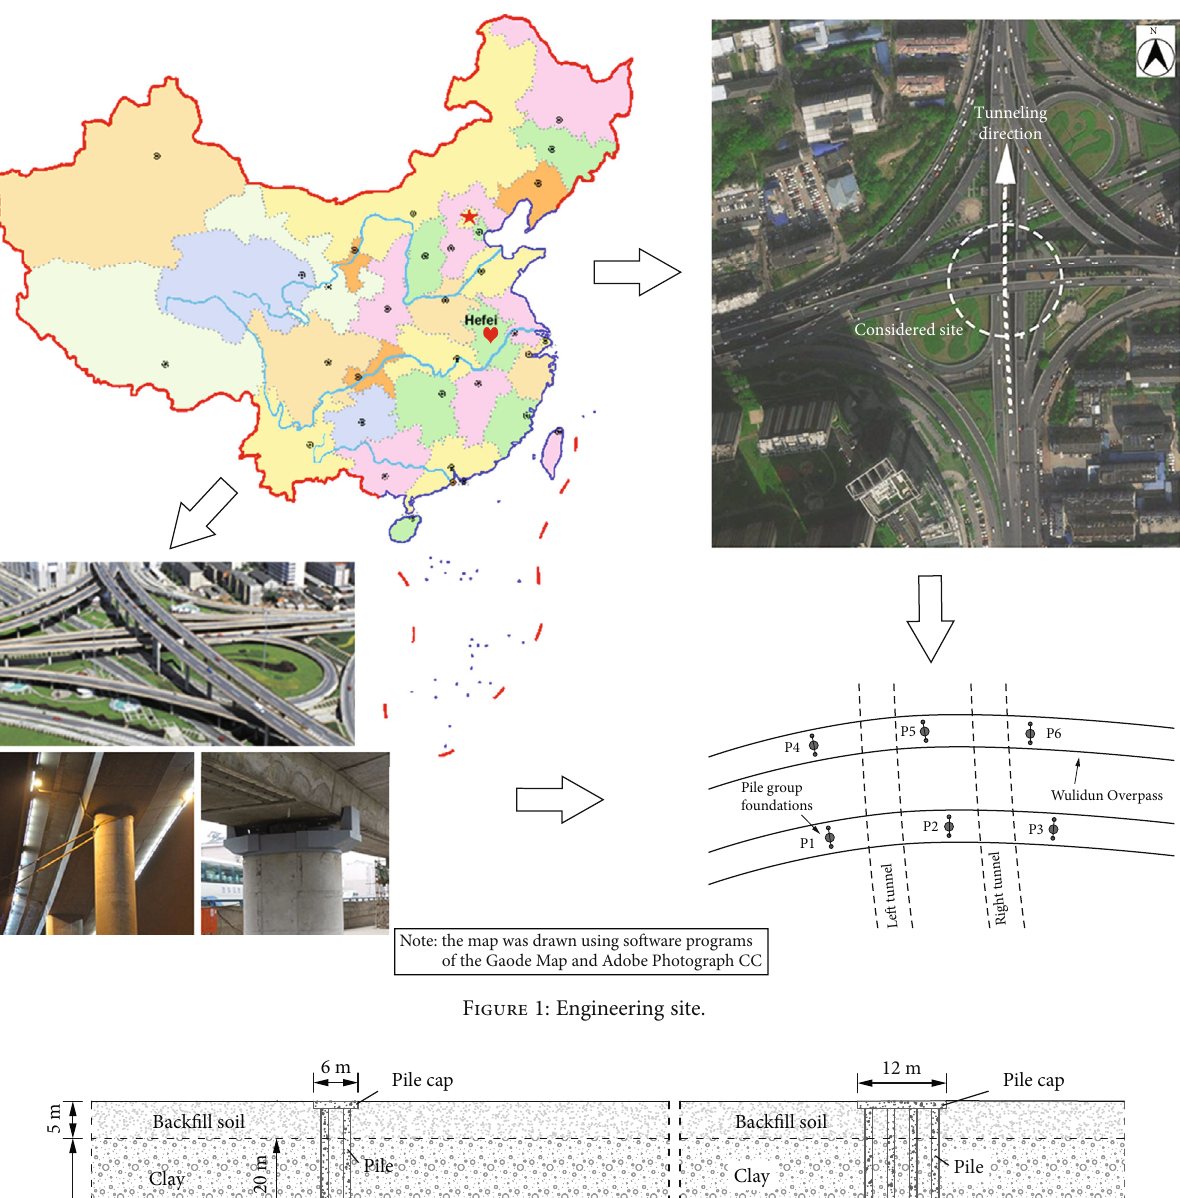
Figure 1: Engineering site.